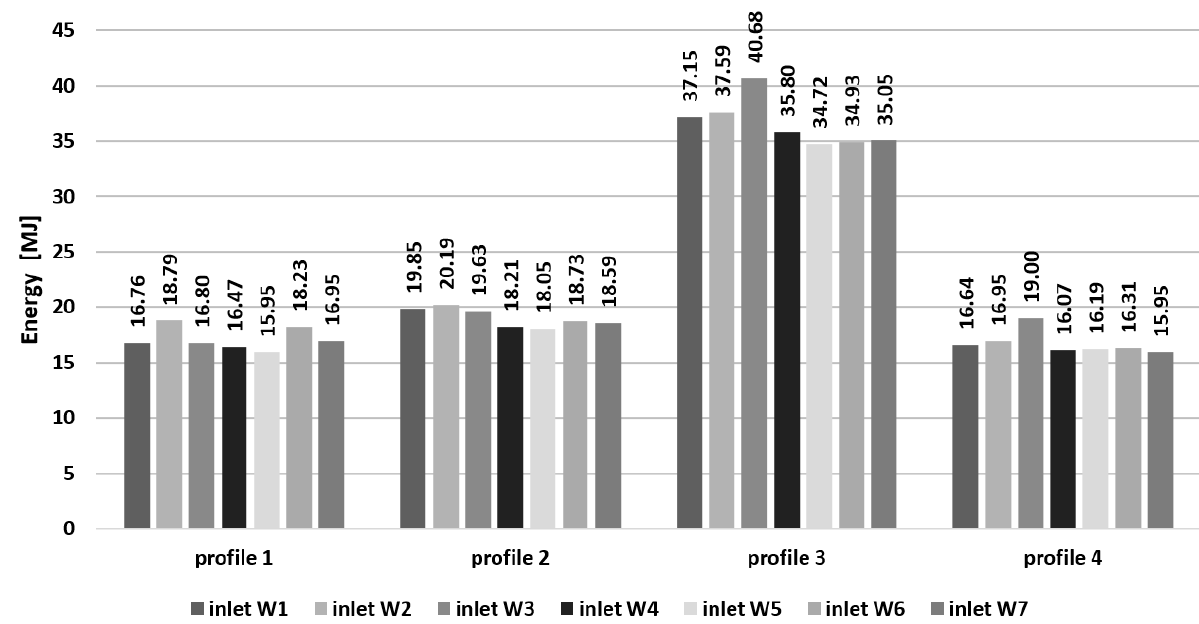
Figure 7. The amount of energy needed to heat the water intake to 55 ◦ C ( E DHW ). While analyzing profile 3, it can be concluded that the most energy-efficient option is also the configuration with inlet W5 (elbow facing down with a single plate), in which the energy demand during the experiment was 34.72 MJ. A small difference could also be seen at inlet W6 (elbow facing upwards with a double plate)—34.93 MJ and at inlet W7 (elbow facing downwards with a double plate)—35.05 MJ. The most energy was used in the variant with inlet W3 (elbow facing down without a plate)—40.68 MJ. The difference between the best and worst cases was 14.65%. However, the greatest difference between the two extreme cases was recorded for profile 4, where it was 16.05%. The most energy- efficient variant with inlet W7 (elbow facing down with a double plate) showed a demand of 15.95 MJ, the worst variant with inlet W3 (elbow facing down without a plate)—19 MJ. Summarizing this part of the analysis, it was noted that the smallest additional energy consumption ( E DHW ), i.e., the highest energy efficiency, was characterized by the W5 inlet because the total consumption in the whole analysis (profiles 1–4) was 84.91 MJ. The W4 inlet was characterized by a slightly higher total consumption (86.55 MJ). These were followed by W6 and W7 inlets, where the total consumption was 88.2 MJ and 86.54 MJ, respectively. Much higher total energy consumption (at 90.4 MJ) occurred in the W1 inlet. In turn, the worst results were obtained for the W2 and W3 inlets, and they are 93.52 MJ and 96.11 MJ,